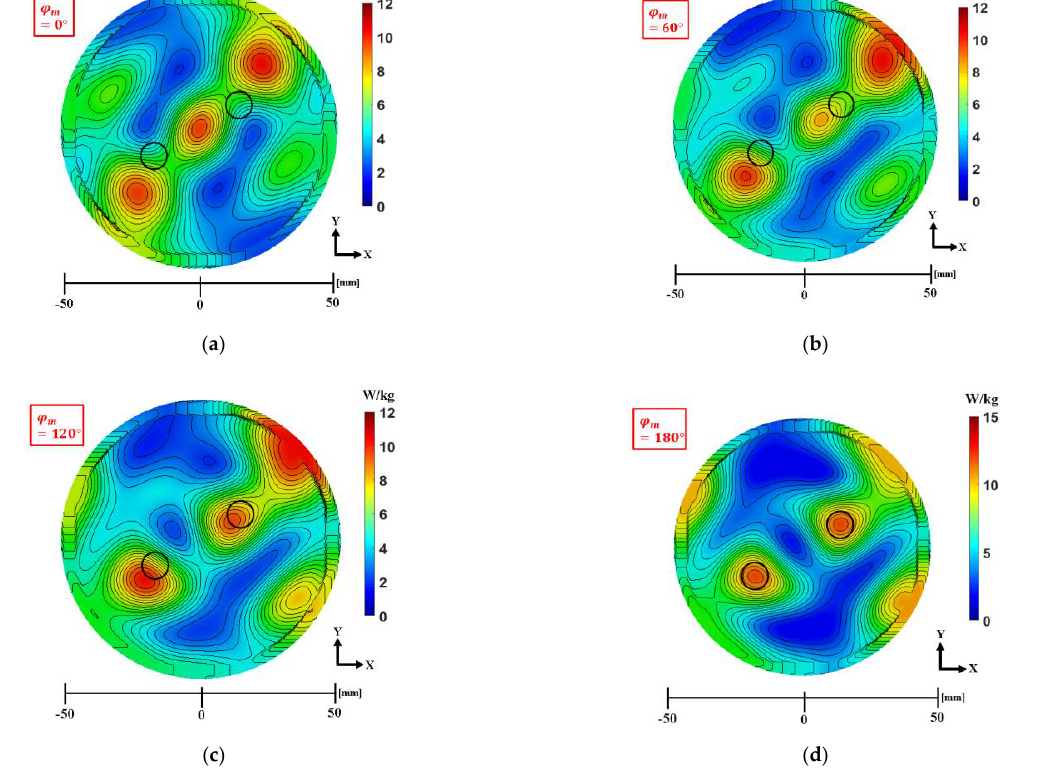
Figure 9. The 2D section of SAR distributions with the phase compensation technique depending on the values of the modified phase (black circles: tumor position): ( a ) ϕ m = 0 ◦ , ( b ) ϕ m = 60 ◦ , ( c ) ϕ m = 120 ◦ and ( d ) ϕ m = 180 ◦ . Table 4. Calculated input phases for multifocal breast cancer for ϕ m = 180 ◦ . Position of Multiple